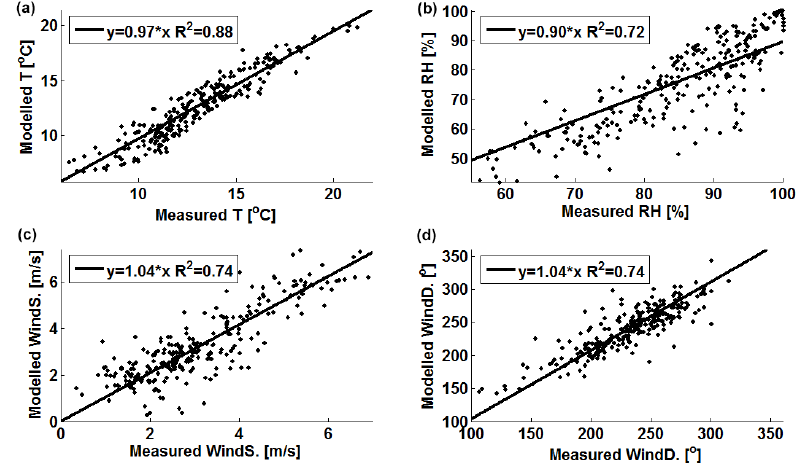
Figure 2. Comparison of meteorological variables between Melpitz ground-based measurements and WRF-Chem D04 result. (a) Tempera- ture; (b) relative humidity; (c) wind speed; (d) wind direction.